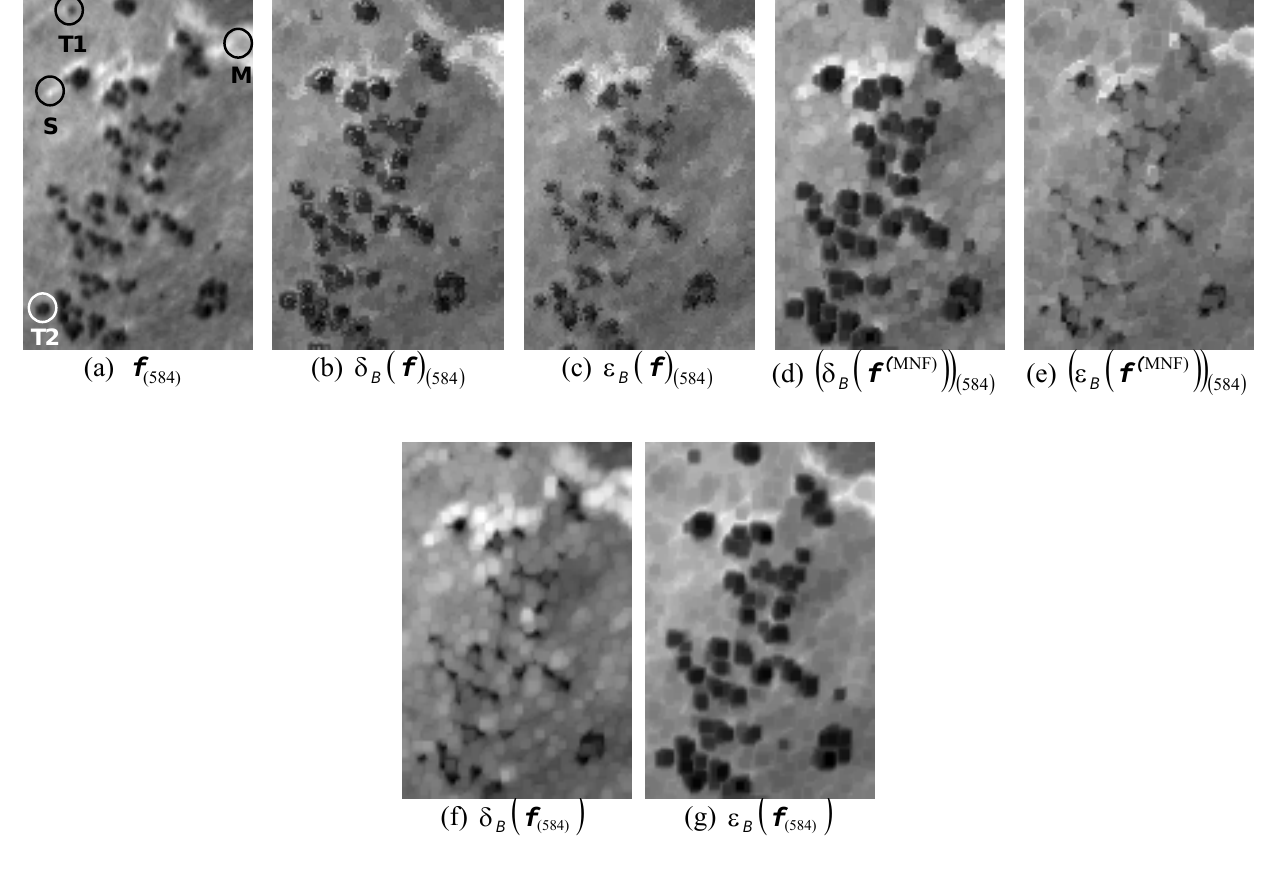
Figure 3. (a) Spectral band at 584 nm of a ROSIS hyperspectral image f . (b) The same band